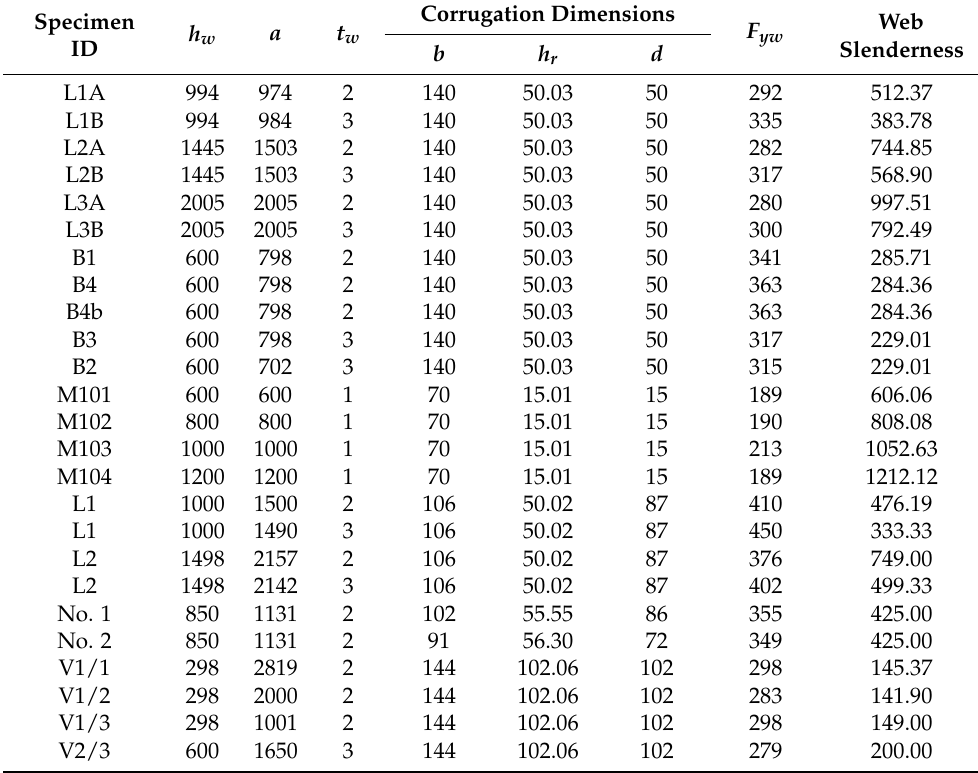
Table A1. Data of specimens tested by Lindner and Aschinger